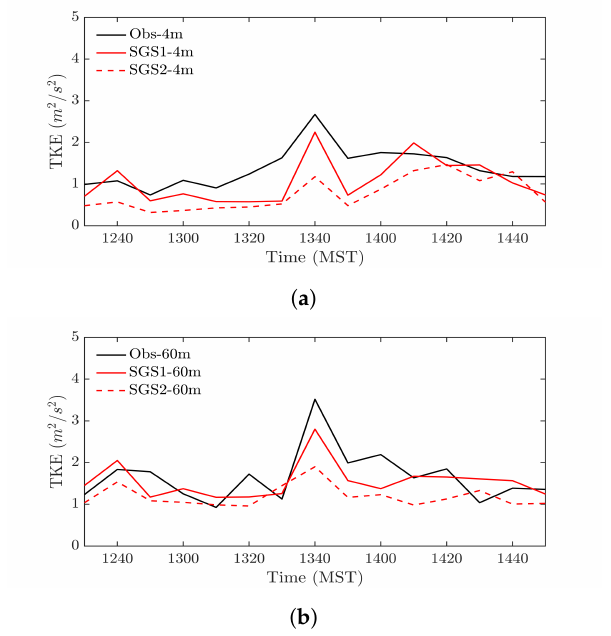
Figure 6. The 10-min averaged ( a ) 4-m and ( b ) 60-m TKE calculated from LES run using 3D TKE SGS model (SGS1) and Smagorinsky SGS model (SGS2), compared against the 3D Sonic anemometer